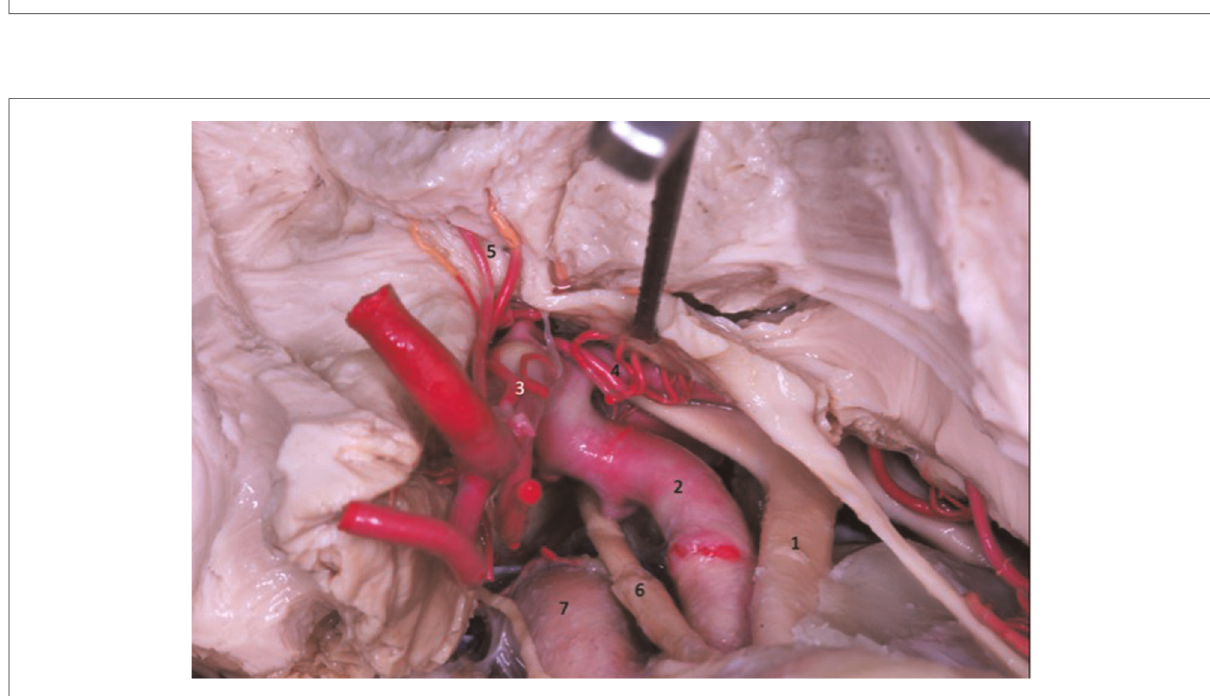
FIGURE 8 The lenticulostriate arteries (4 and 5) penetrate the anterior perforated substance and ascend to the basal nuclei and internal capsule. 1 - Optic nerve; 2 - internal carotid artery; 3 - anterior cerebral artery; 4 - medial lenticulostriate artery; 5 - medial lenticulostriate artery; 6 - oculomotor nerve; 7 - intracavernous internal carotid